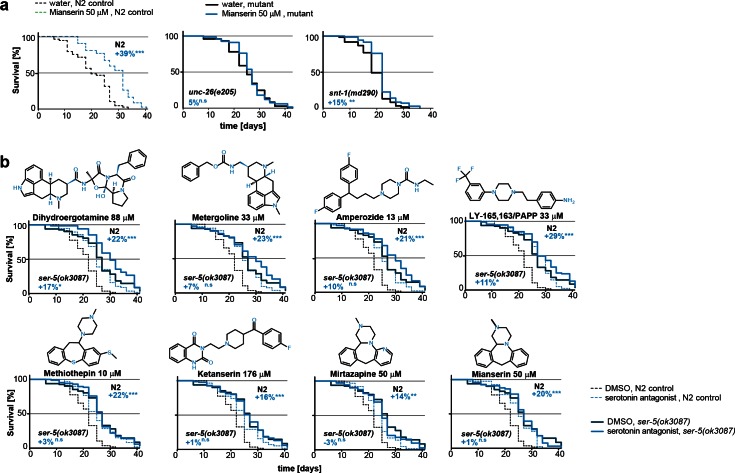
This figure relates to Figure 5e in main text.(a) Kaplan-Meier graphs for lifespan of wt (dotted line) and synaptic mutant animals treated with water (black) or mianserin (blue). Synaptic transmission is required for mianserin-induced lifespan extension. For detailed statistics, see Table 8. (b) Kaplan-Meier graphs for lifespan of wt (dotted lines), ser-5(ok3087), (solid lines) treated with DMSO or serotonin antagonists namely: Dihydroergotamine, Metergoline, Amperozide, Methiothepin, Ketanserin, Mirtazapine, LY-165,163/PAPP or mianserin, on day 1 of adulthood. All 8 serotonergic antagonists completely or partially depend on ser-5.